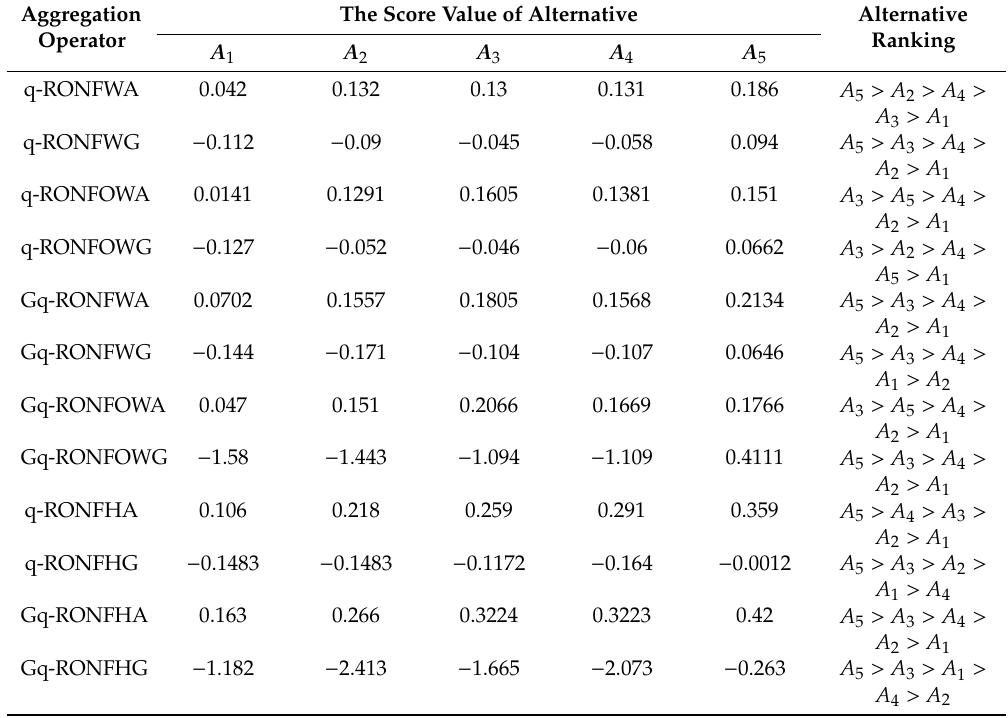
Table 3. Schemes sorting results based on di ff erent aggregation